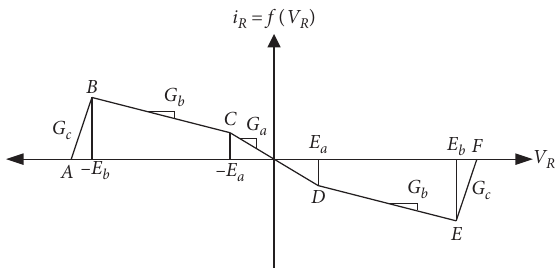
Figure 2: Five-segment piecewise linear V − I characteristic of the nonlinear